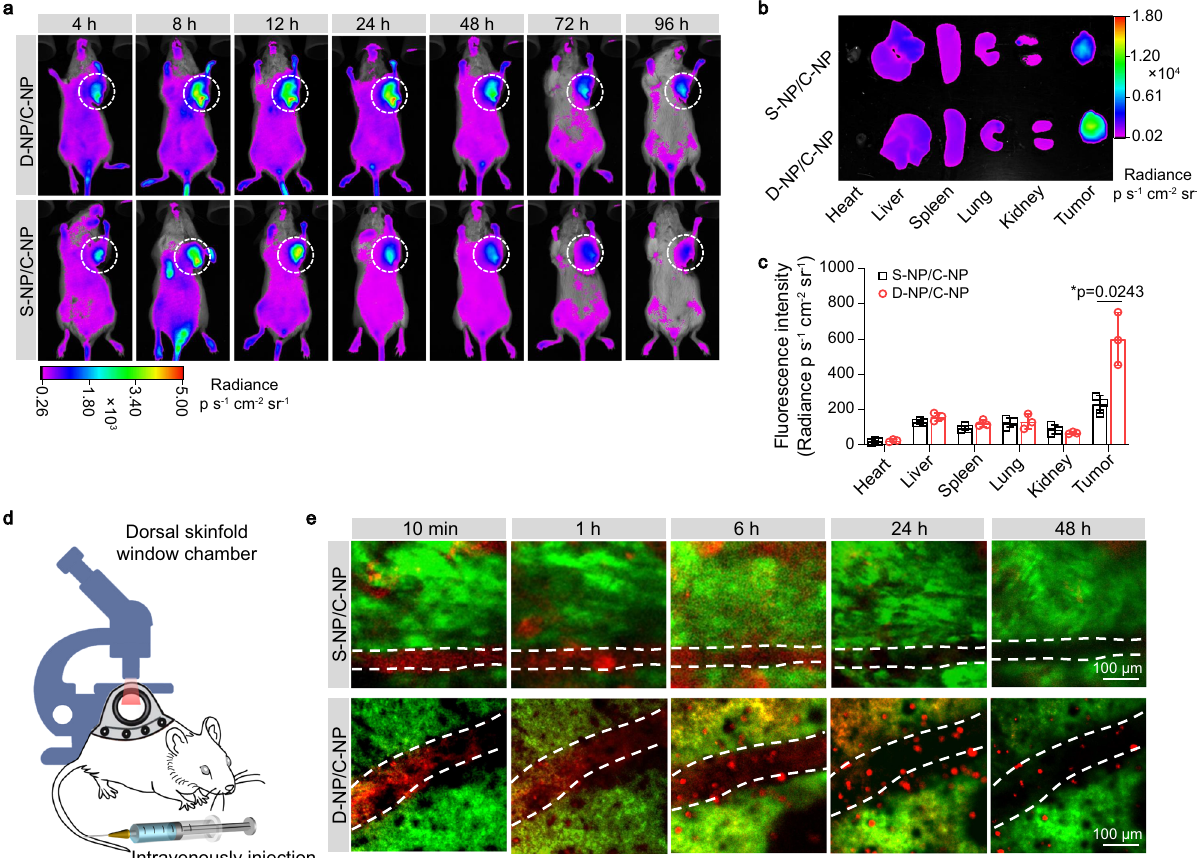
Fig. 3 Intratumoral in situ assembly of D-NP/C-NP achieves long retention and enrichment of the NPs in the tumor site to serve as drug depots. a IVIS imaging of 4T1 tumor-bearing mice at different times after i.v. injection of the mixture of D-NP plus C-NP (D-NP/C-NP) or S-NP plus C-NP (S-NP/C-NP) ( n = 3). The NPs were labeled with DiD. White circles indicate the tumor sites. b Representative ex vivo imaging of the tumor tissues and major organs after i.v. injection of D-NP/C-NP or S-NP/C-NP at 96 h post-injection. c ROI analysis of the fl uorescent signals of the collected tumor tissue and major organs in b . Data are presented as the mean ± s.d. ( n = 3). Statistical signi fi cance was calculated via Student ’ s t -test (two-tails) in c . * p < 0.05. d Schematic showing the use of intravital CLSM to visualize the intratumoral in situ assembly and long retention of D-NP/C-NP in real time. e Intravital CLSM real-time visualization of D-NP/C-NP and S-NP/C-NP tumor accumulation in GFP-4T1 tumor-bearing mice. Both D-NP/C-NP and S-NP/C-NP were labeled with Cy5. A representative image from one of fi ve independent fi elds of view in a single experiment. Source data are provided as a Source Data fi